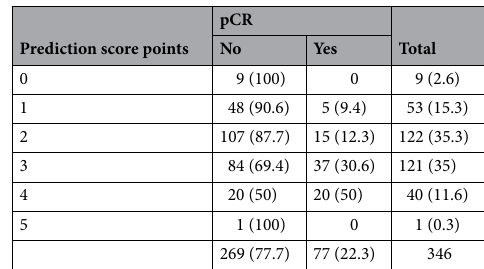
Prediction score